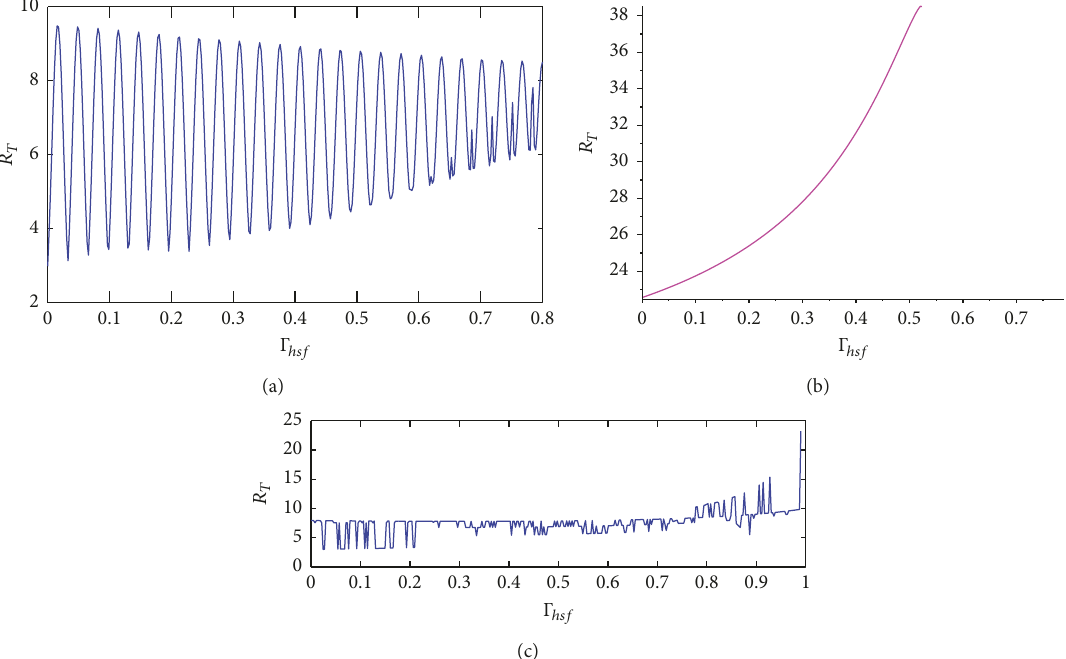
Figure 9: The effect of increased infection rate to fleas from the infectious human beings ( 𝐼 𝐻𝑆 ) on the periodic reproduction number.